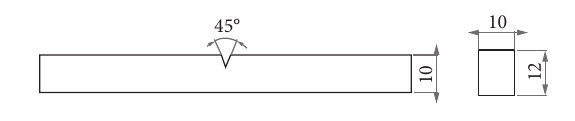
Figure 3: Schematic image of the impact